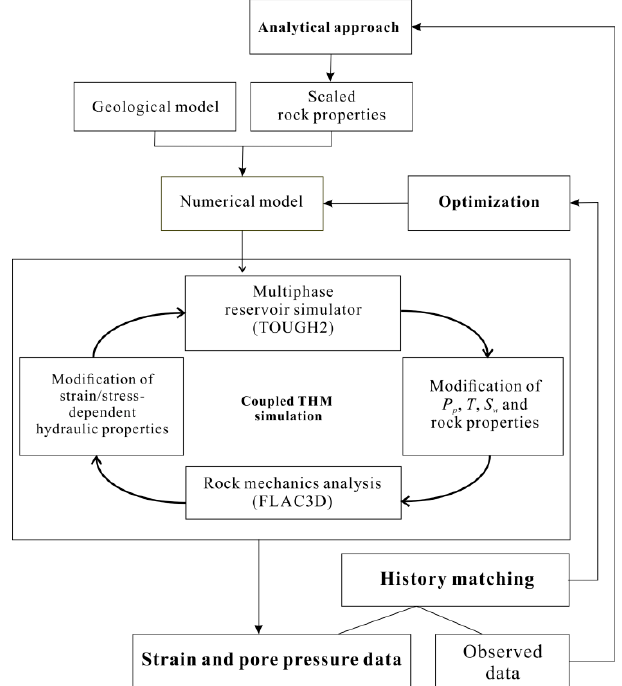
Figure 1. Framework of geomechanical modeling with coupled thermal, hydrological, and mechanical (THM) simulation and history matching using distributed strain data, for which no geophysical post processors are